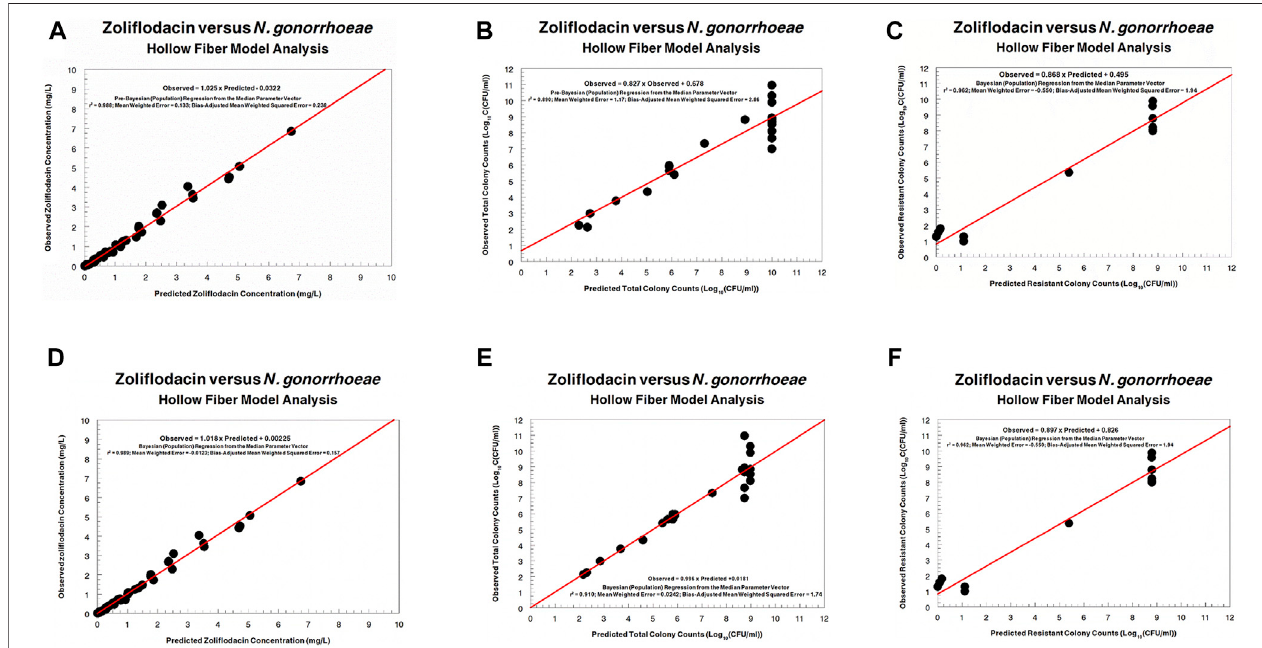
FIGURE3| Predicted – observedregressionsforzoli fl odacinconcentrations,total Neisseriagonorrhoeae burden,andresistant N.gonorrhoeae burdenforthepre- Bayesian regression (A – C) and for the Bayesian regressions (D – F) for WHO F.